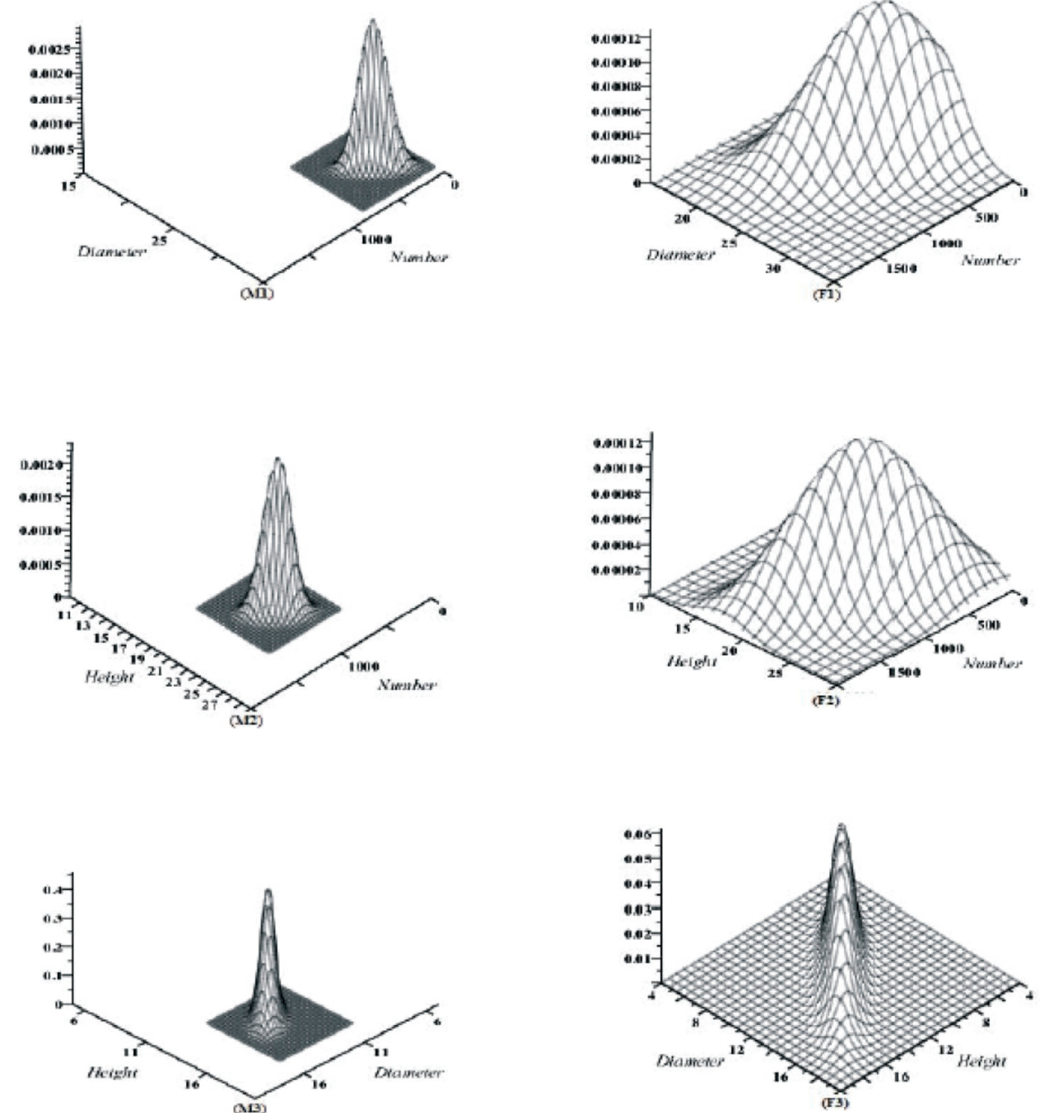
Figure 2. Estimated marginal bivariate density functions for three randomly selected stands. ( M1 – M3 ) mixed effects scenario; ( F1 – F3 ) fixed effects scenario; ( M1 – F1 ) the first stand (age 96 years), quadratic mean diameter and number of trees per hectare; ( M2 – F2 ) the second stand (age 65 years), mean height and number of trees per hectare; ( M3 – F3 ) the third stand (age 29 years), mean height, and quadratic mean diameter.